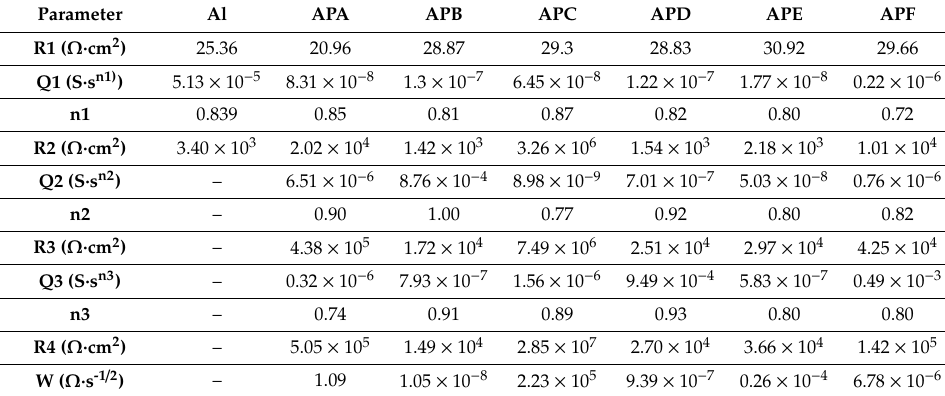
Table 6. EIS fitting parameters of all PEO coatings and Al substrate obtained from the equivalent electrical